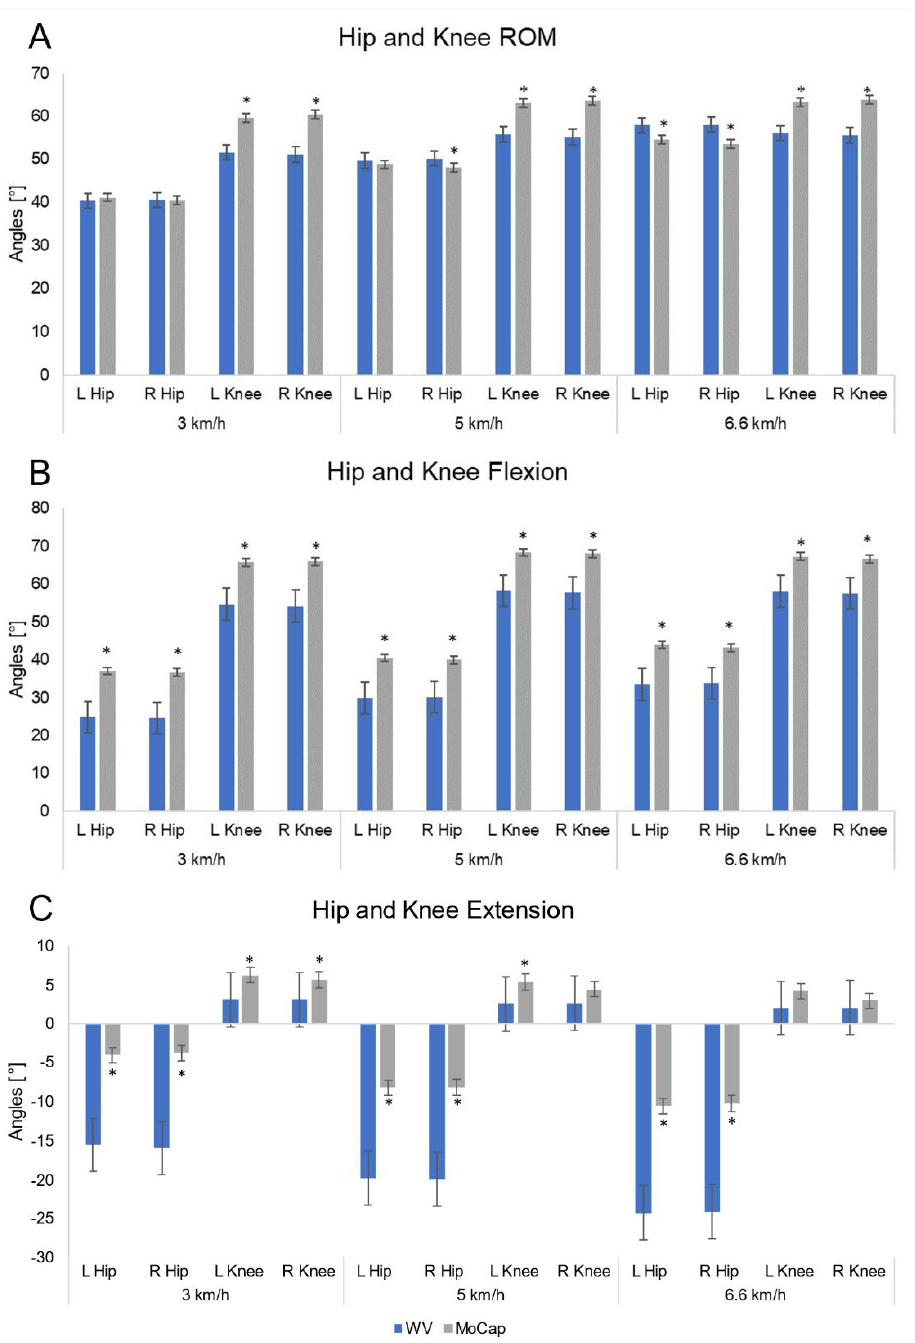
Figure 5. Mean and Standard Deviations (SD) of hip and knee joints total range of motion (ROM). ( A ) Flexion ( B ) and extension ( C ) angular displacements in the sagittal plane at three walking speeds. ( A ) WalkerView TM (WV) overestimated hip ROM at 5 km/h and 6.6 km/h and underestimated knee ROM at all walking speeds. ( B ) WV hip and knee peak flexion were lower than those recorded by MoCap at all walking speeds. ( C ) WV recorded greater hip extension peak measured than MoCap; knee extension peak was underestimated by WV at 3 km/h and only for the left knee at 5 km/h. Asterisks (*) indicate statistically significant differences ( p < 0.05-Wilcoxon signed-rank test).